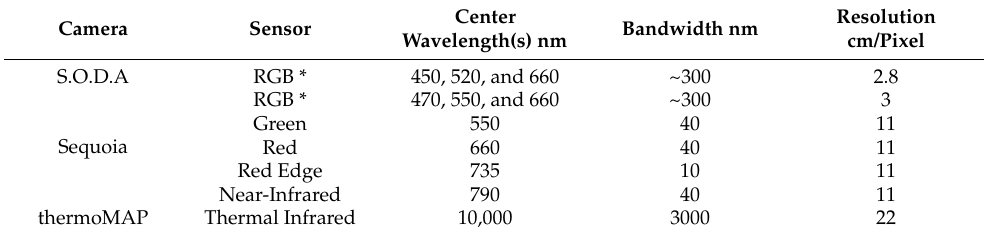
Table 2. Camera specifications and spatial resolution for the UAV flights performed at approximately 117 m